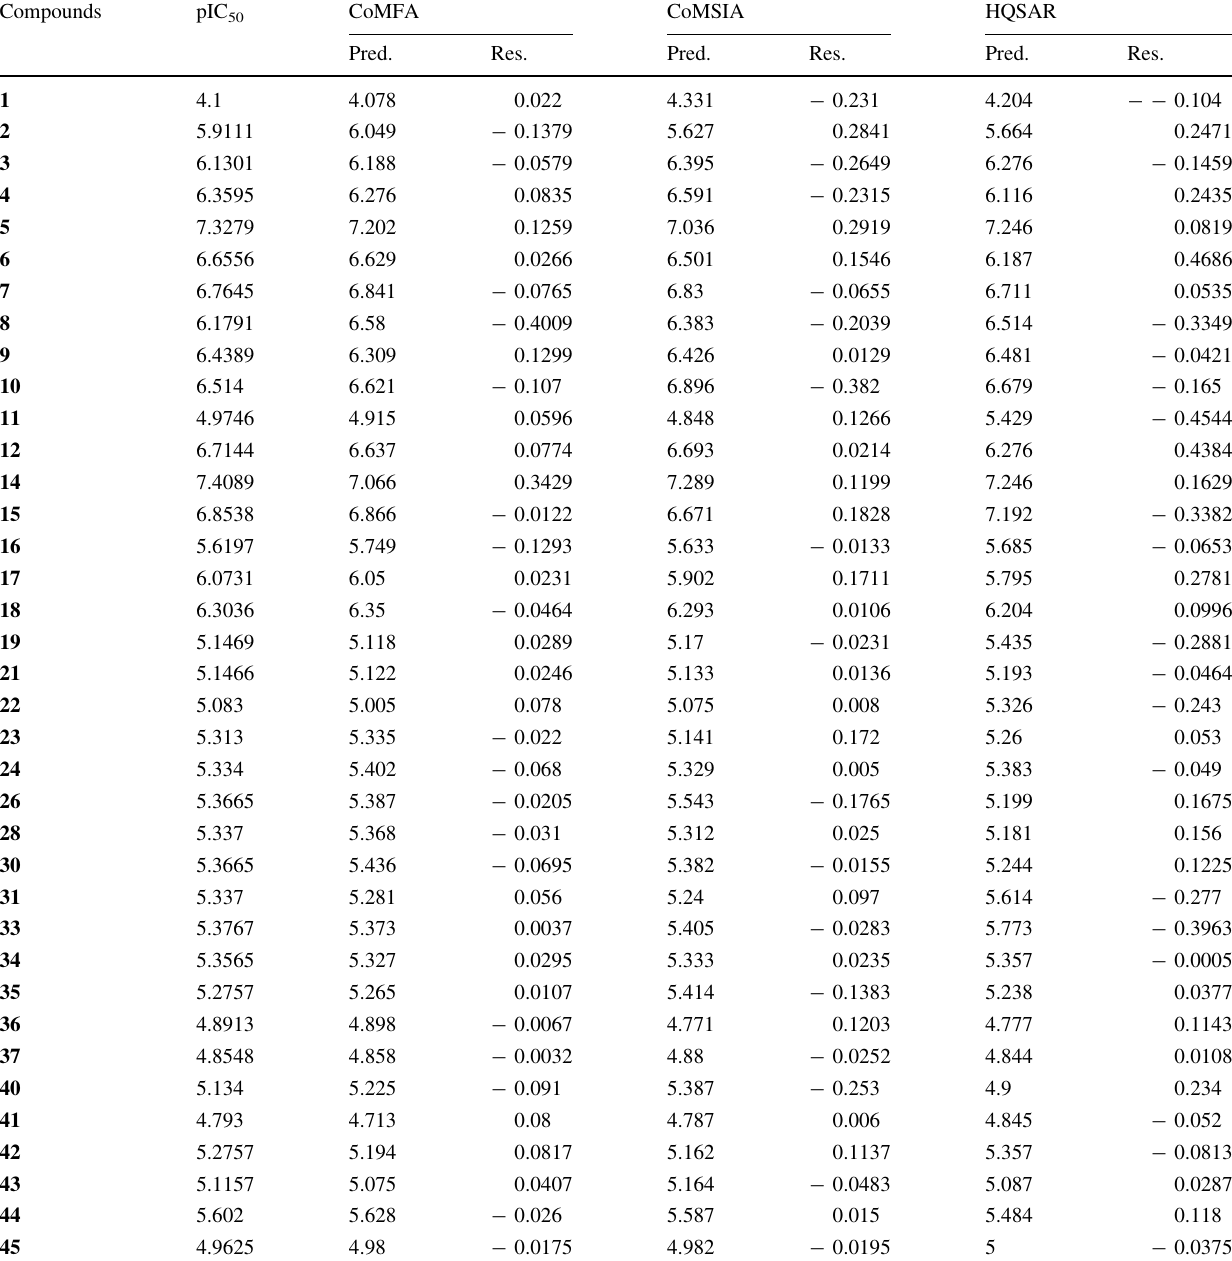
Table 4 Experimental dates, prediction values and its residues of the training set used for the CoMFA, CoMSIA and HQSAR Compounds pIC 50 CoMFA CoMSIA HQSAR Pred. Res. Pred. Res.